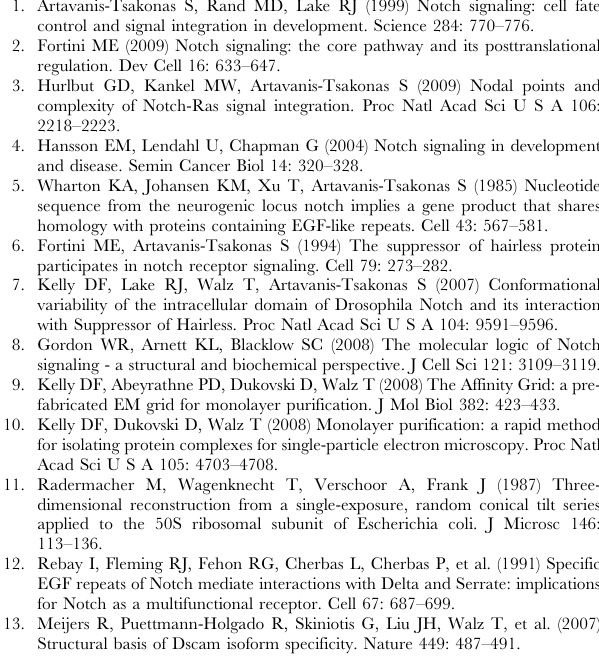
Figure S3 (A) Images of untilted (left panel) and 50 u tilted (right panel) specimens of human NECD in cryo-negative stain. Circles indicate individual particles. Black line indicates tilt axis. (B) Averages obtained by classifying the 12,393 particles selected from the images of untilted specimens of cryo-negatively stained human NECD into 20 classes. The side length of the individual panels is 43 nm. Figure S4 Fourier shell correlation (FSC) curves (green, black and red) indicate a resolution of 25 A˚ for all Drosophila (A) and human (B) NECD density maps. Figure S5 Antibody labeling of Drosophila NECD. Class average (left) and a gallery of particle images (right) for Drosophila NECD labeled with the antibody against the ligand-binding site (LBS Ab - top row) and for Drosophila NECD labeled with the anti-Flag antibody (Flag Ab - bottom row). The side length of the individual panels is 43